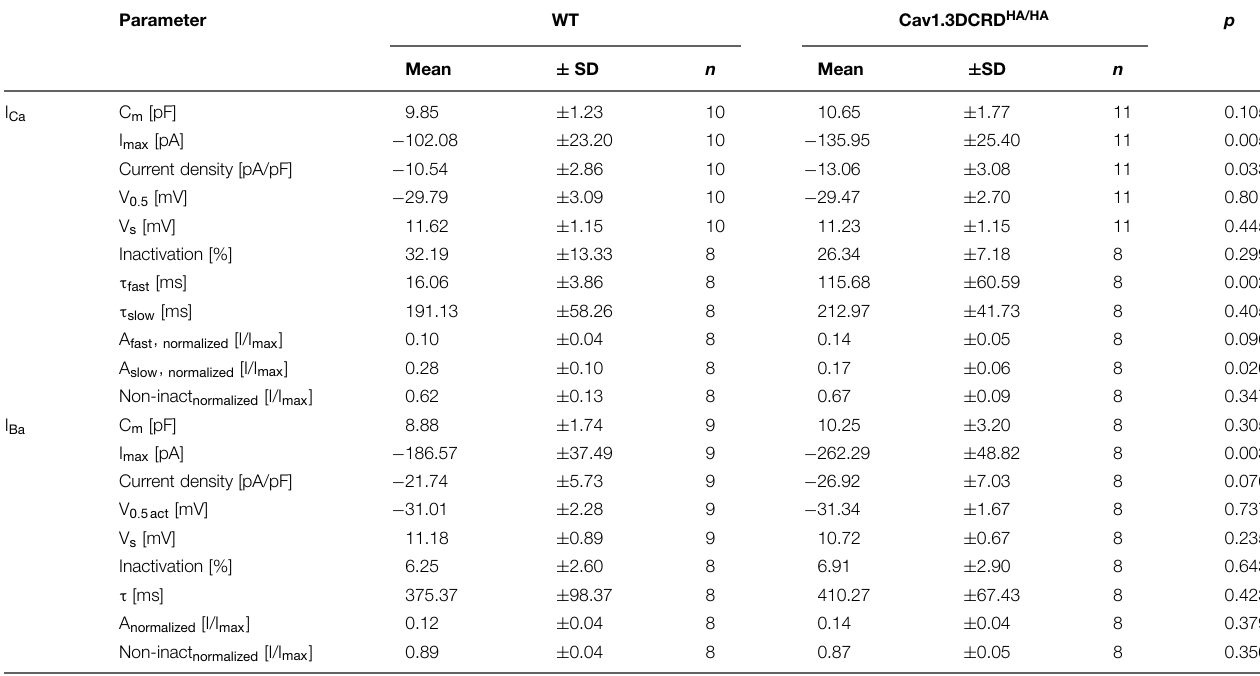
TABLE 2 | Properties of IHC Ca 2 + channel currents of Cav1.3DCRD HA / HA mice and wild-type (WT) littermates. Parameter